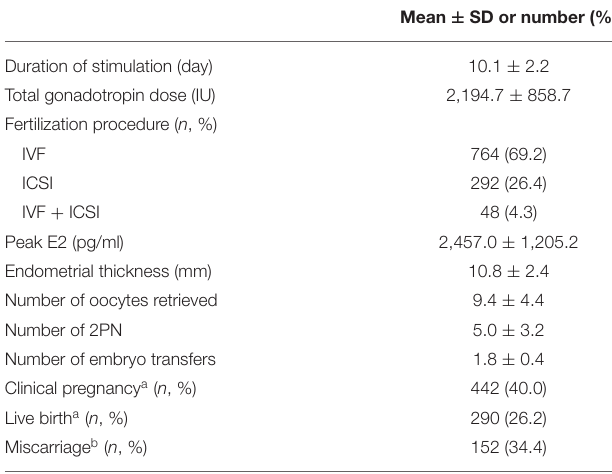
TABLE 1 | Characteristics of included women. TABLE 2 | Treatment outcomes of included